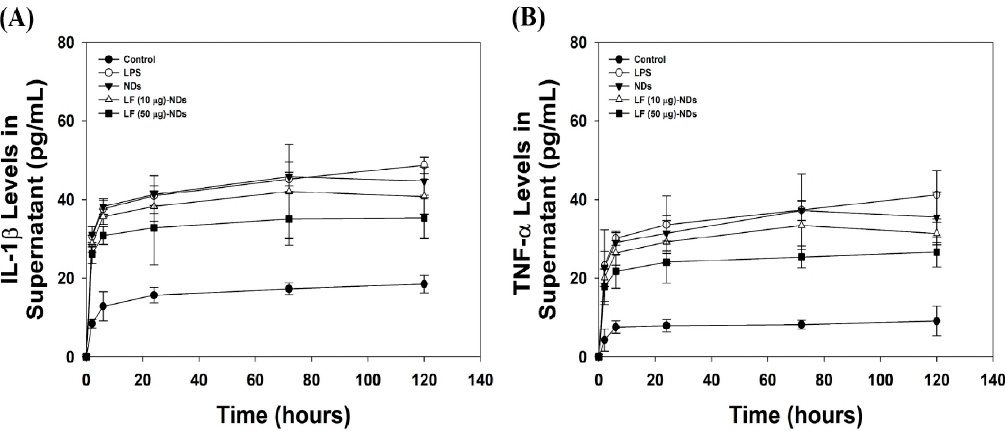
Figure 7. ( A ) IL-1 β and ( B ) TNF- α levels in cell supernatant secreted by LPS-stimulated cells treated with NDs with or without LF at 2, 6, 24, 72 and 120 h by